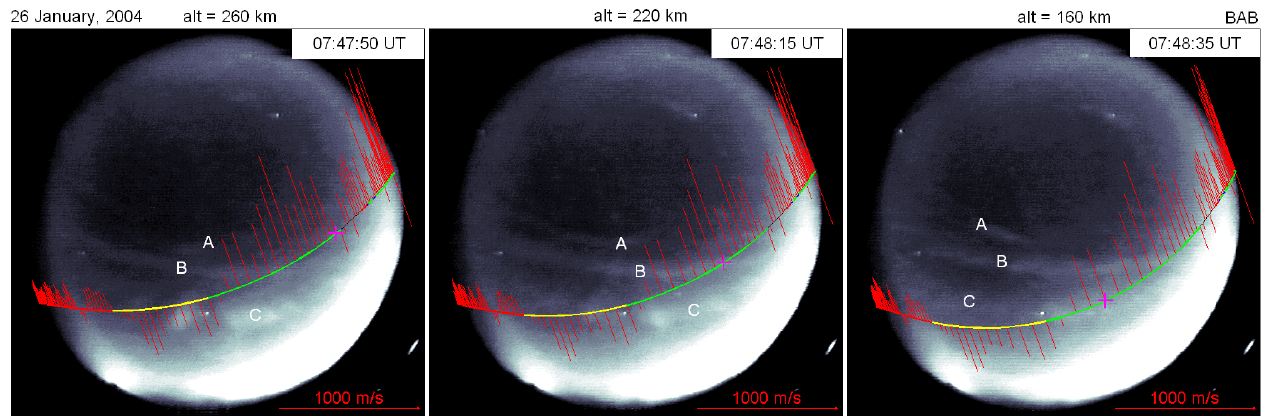
Fig. 3. The DMSP trajectory mapped on the TV frames. The cross shows the DMSP position at the moment indicated on each frame. The green fragment corresponds to llbl , the yellow fragment is bps . Red arrows are the components of plasma velocity perpendicular to the DMSP trajectory. Arcs A, B and C correspond to the structures A, B and C in precipitating particles shown in Fig. 2. North (geographic) is on the top of each frame, west is on the left. The specious white area in the south-east is